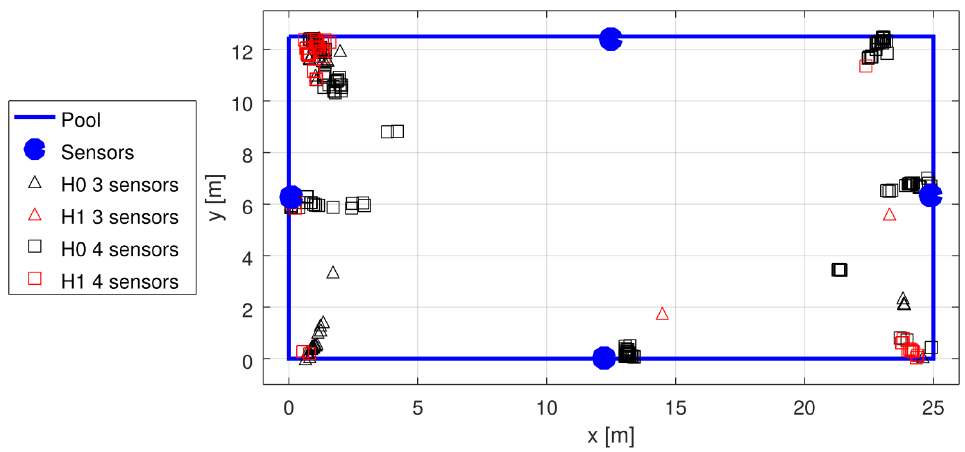
Figure 17. Localization results in sport pool test 3; the transmitter was placed in seven locations (close to the corners and to three